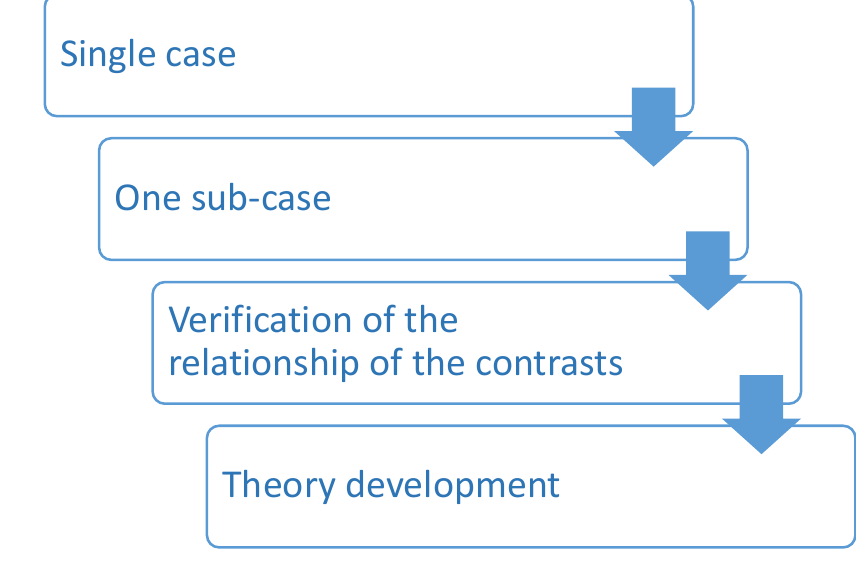
Figure 1. Single case study single